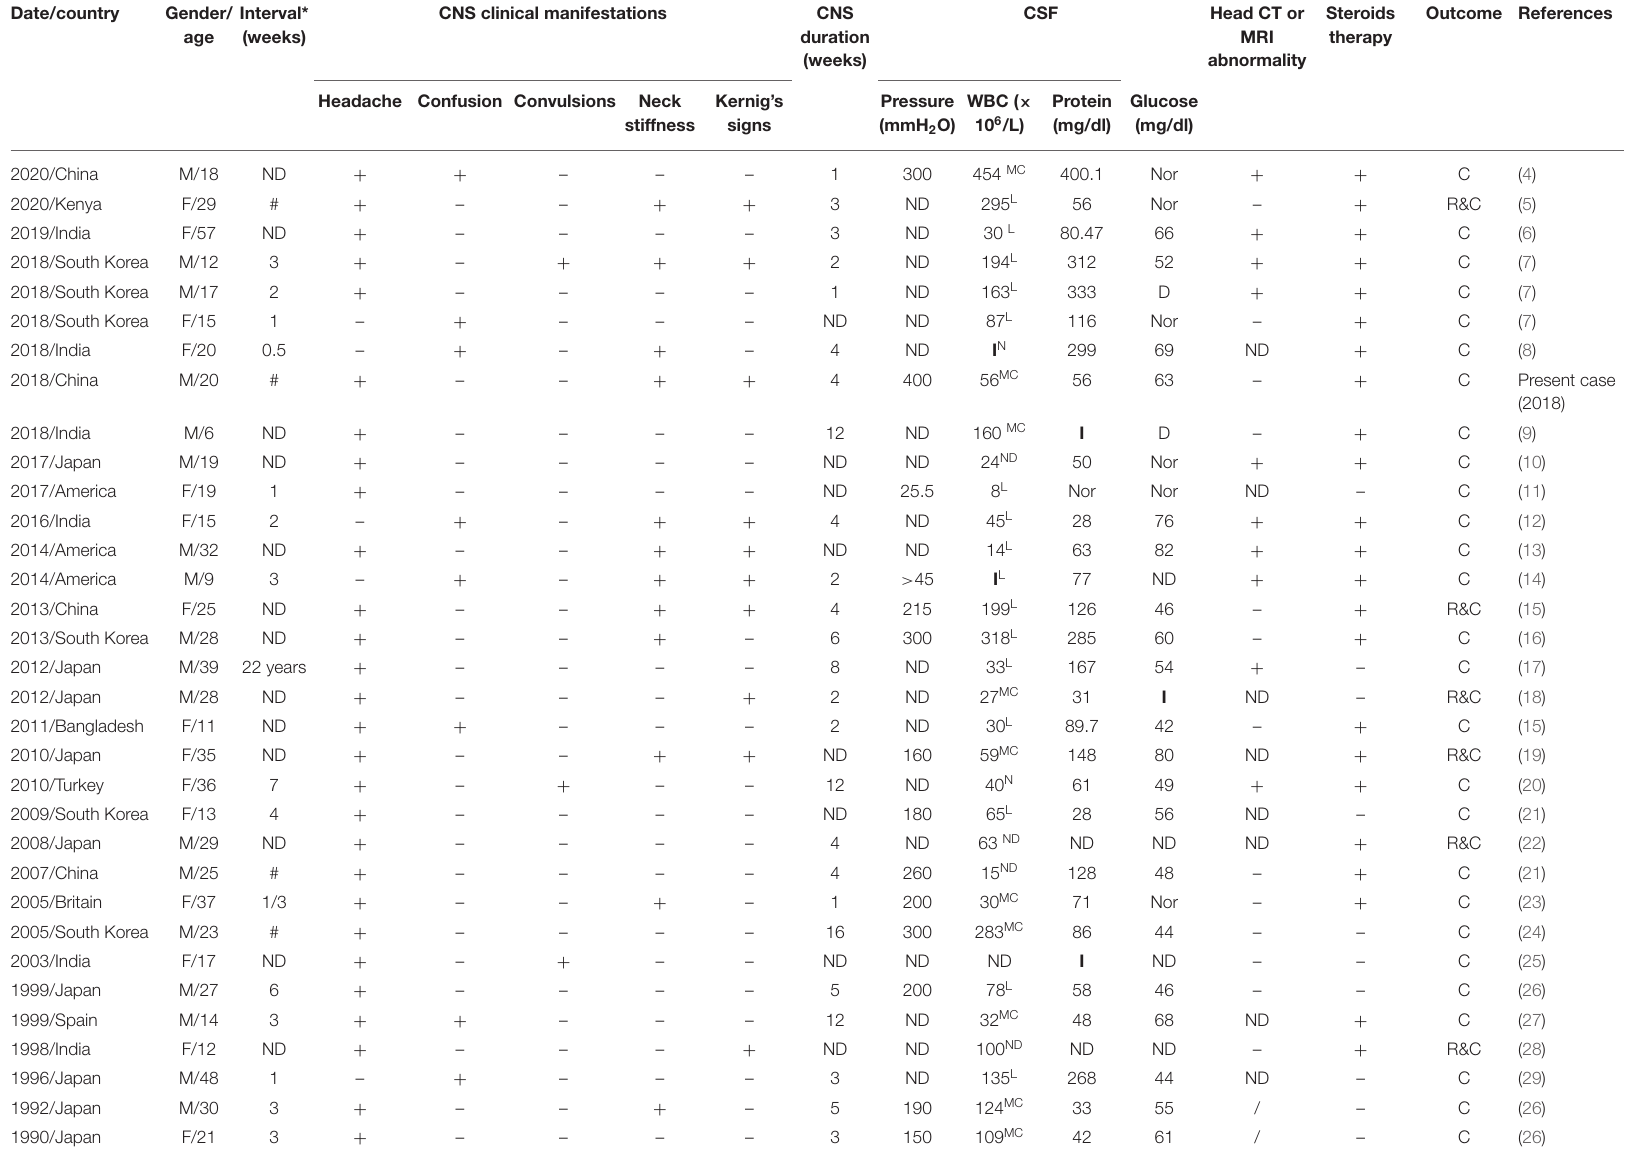
TABLE 2 | The clinical features of recurrent aseptic meningitis cases with Kikuchi–Fujimoto